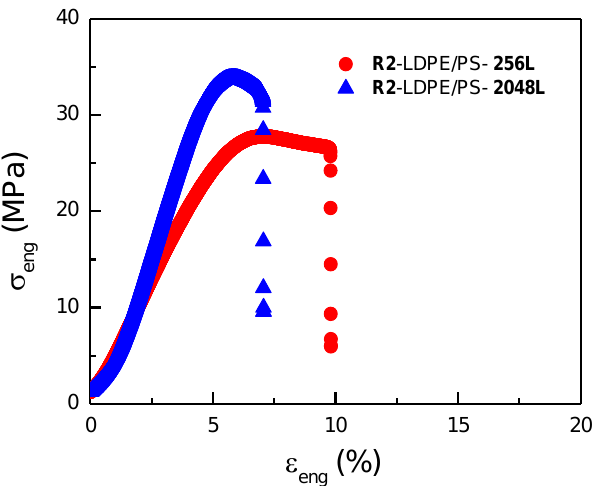
Figure 8. Engineering stress-strain plot of the recycled R2-LDPE/PS (10/90) multilayer films (MD) with different numbers of layers.